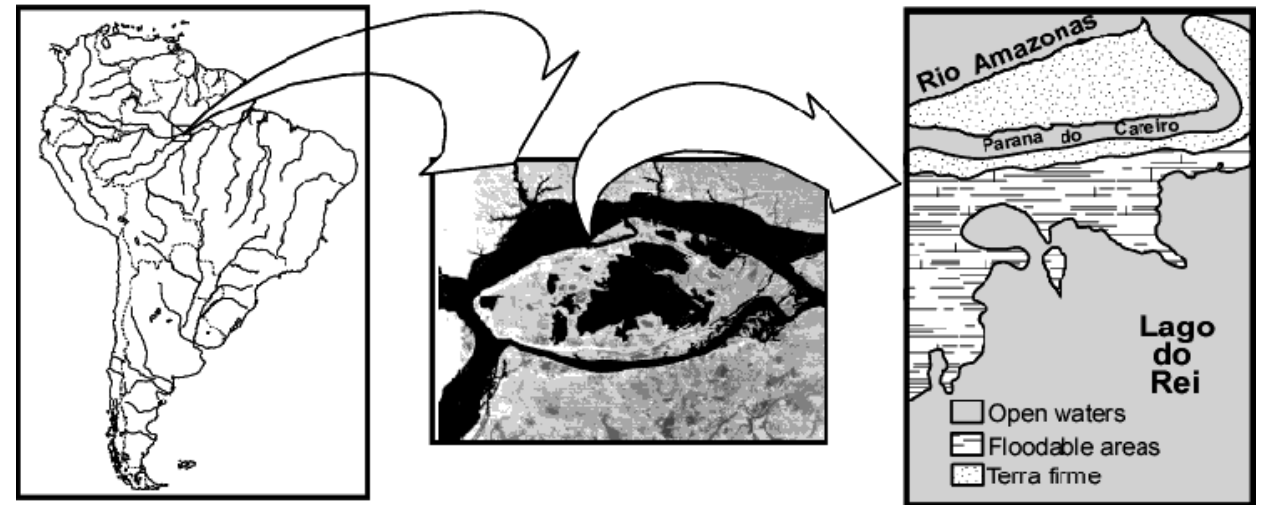
Fig. 1. Localization of the lago do Rei and detail of the study site in the northern